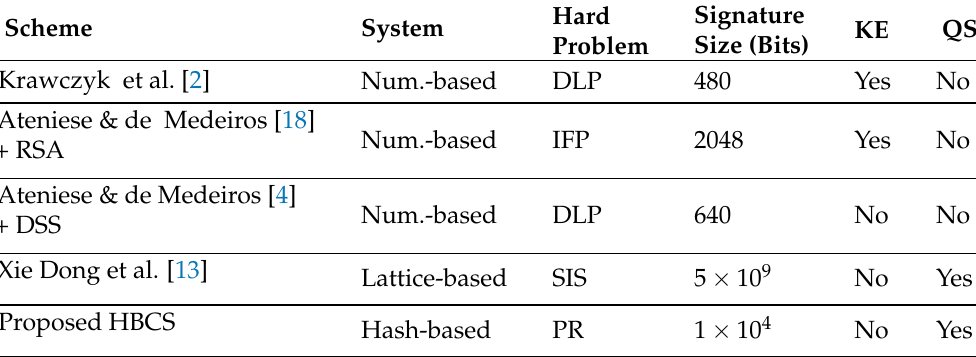
Table 2. Comparison of the proposed HBCS scheme with existing chameleon signature